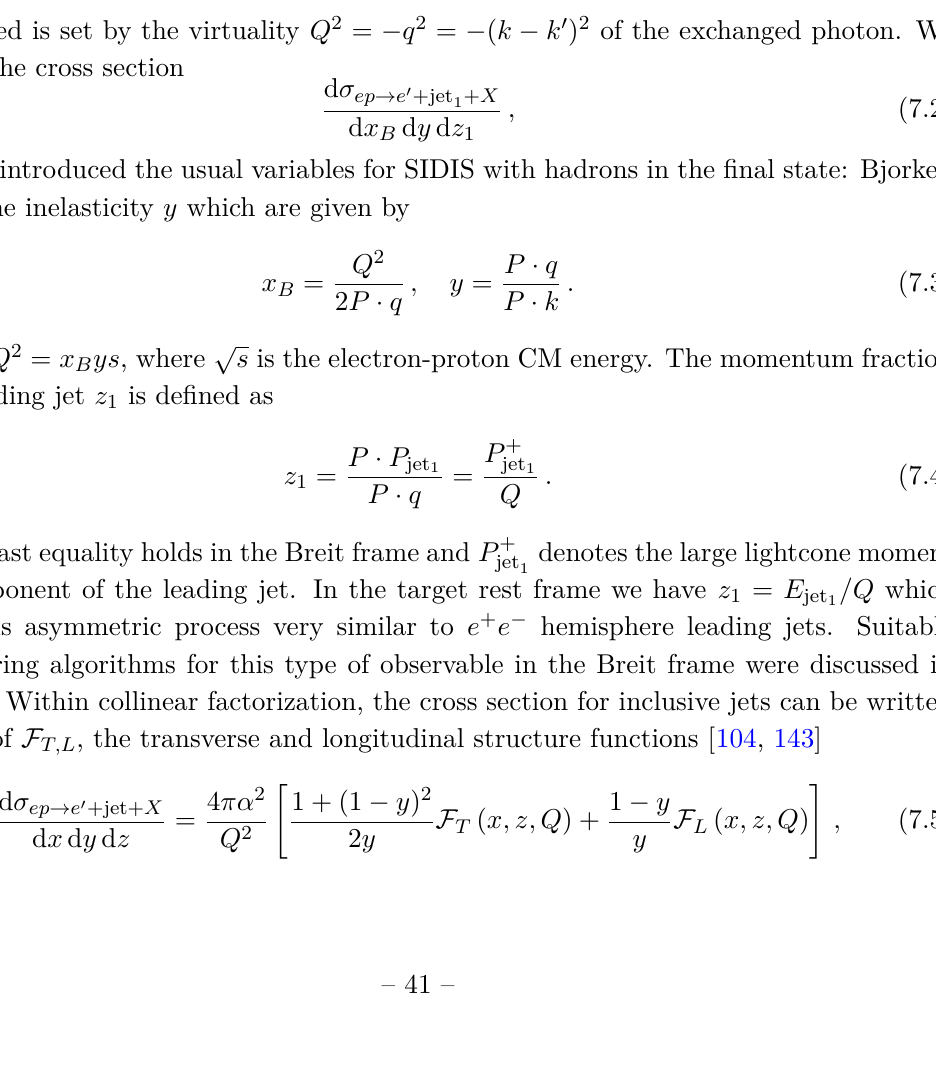
is measured is set by the virtuality Q 2 = − q 2 = − ( k − k 0 ) 2 of the exchanged photon.